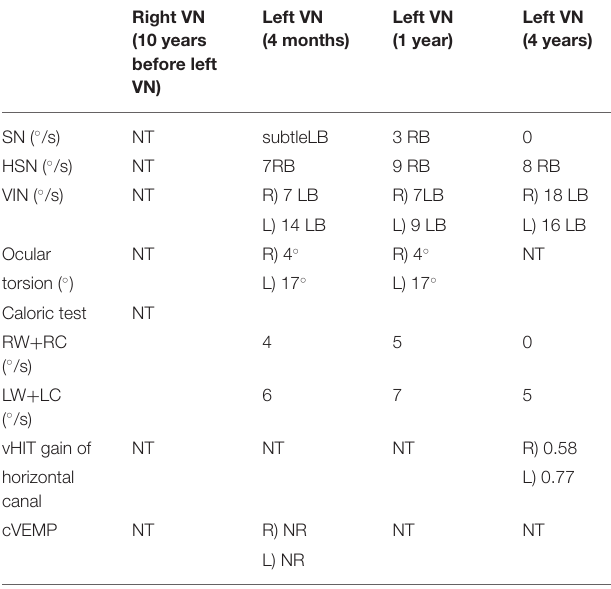
TABLE 1 | A summary of changes of vestibular function in case